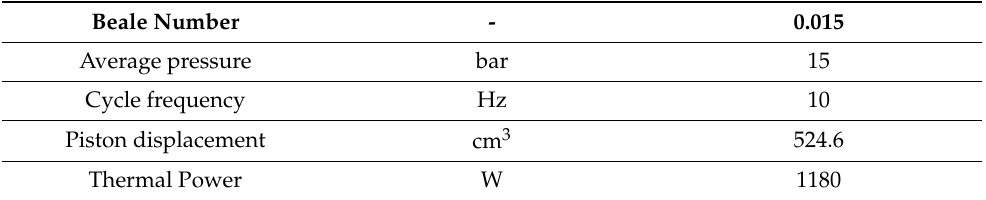
Table 6. First-order power calculation.